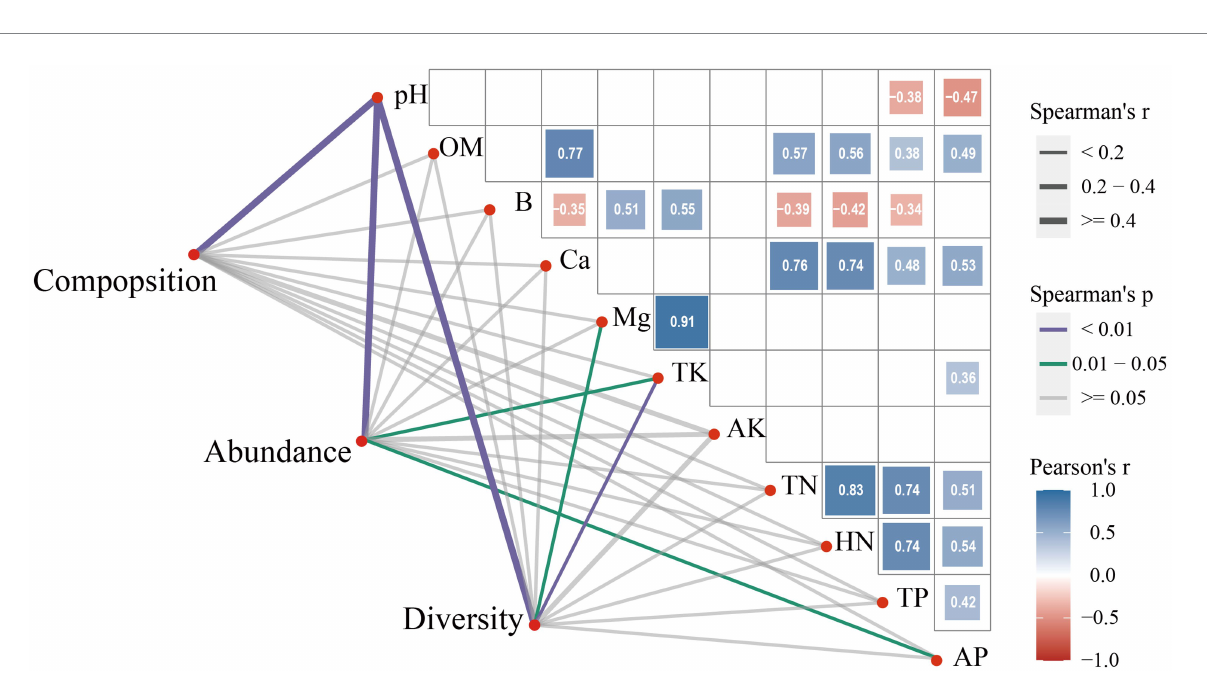
FIGURE 8 Correlation of soil properties with microbial composition, abundance, and